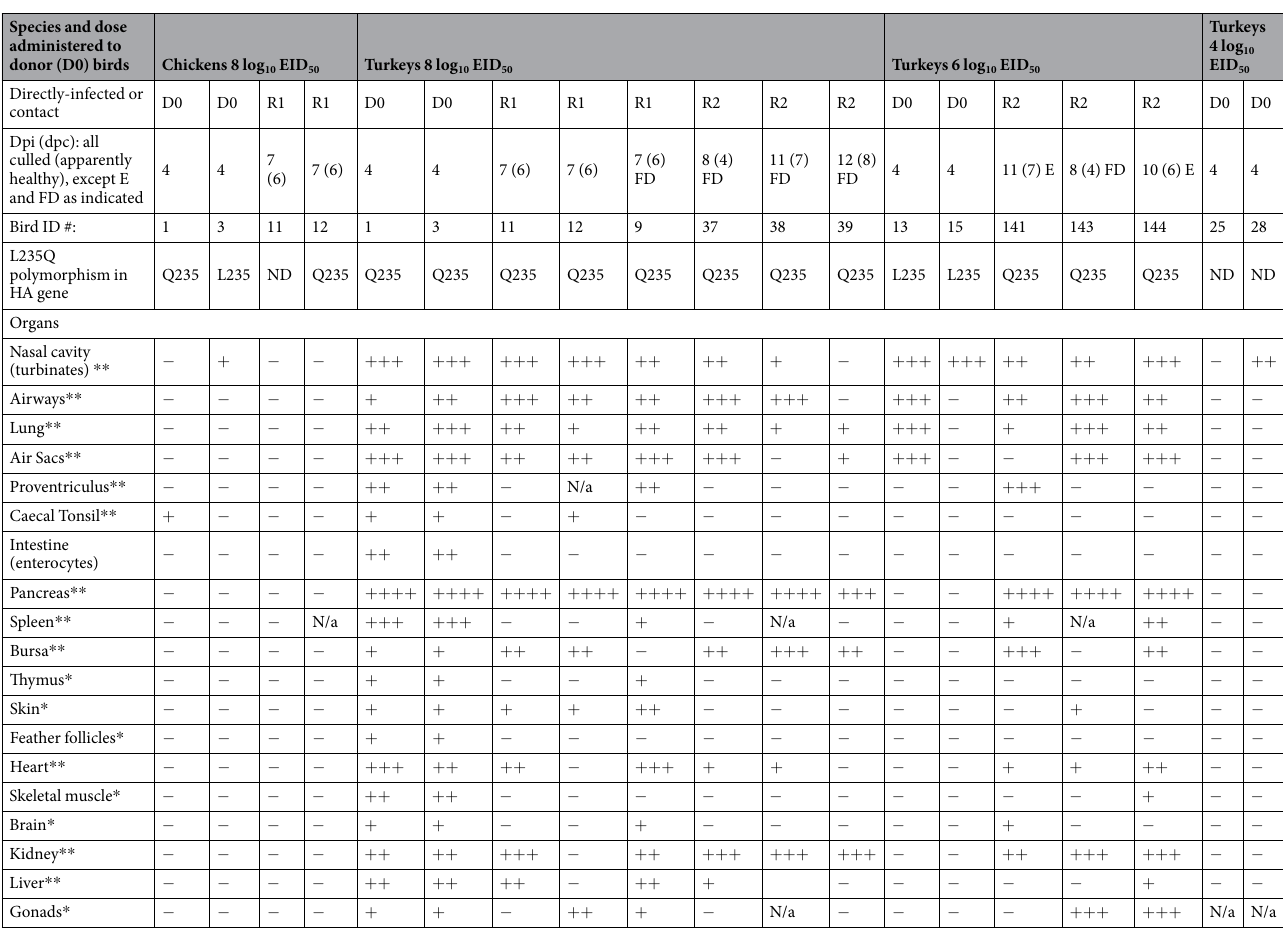
Table 1. Detection of IAV NP antigen in organs by immunohistochemistry. Four experimental groups indicated in the header, divided by D0 species and direct dose of H7N9wt (log 10 EID 50 ). E = euthanised, FD = found dead. L235Q polymorphisms indicated for individual birds at time of cull or death. * Detected only in endothelial cells; ** Detected in endothelial and parenchymal cells. N/a: not available; ND not